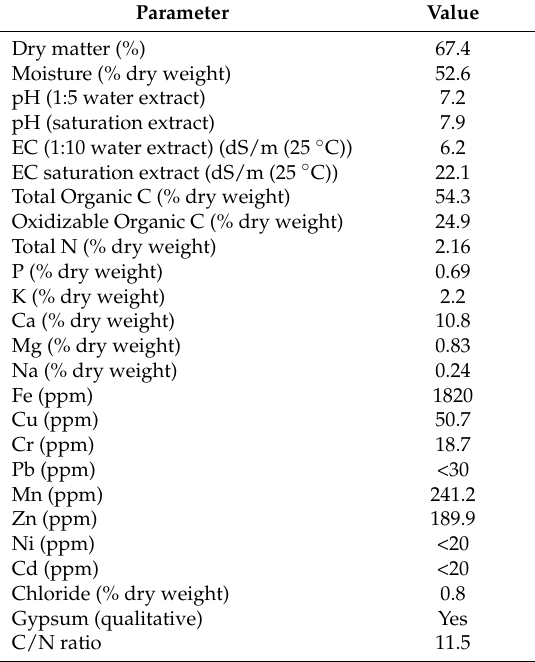
Table 2. Physicochemical properties of raw